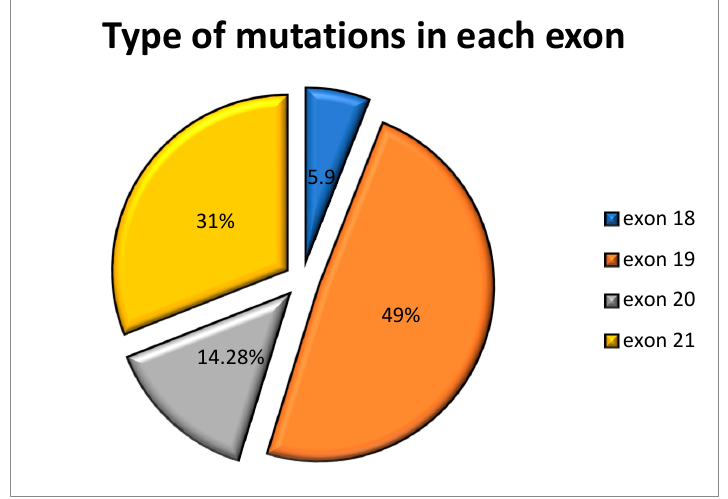
Figure 2. Percent representation of mutations present in EGFR gene exons 18, 19, 20, and 21. Table 2 provides the exon location of EGFR mutations according to different lung cancer types. Only adenocarcinoma samples showed EGFR mutations in all four exons tested, i.e., 18, 19, 20, and 21. Squamous cell carcinoma and adenosquamous carcinoma had mutations in three of the four exons, 18, 19, 21, and 18, 20, 21, respectively, carcino- sarcoma in exon 21, undifferentiated carcinoma in exon 19, and sarcomatoid carcinoma in exon 18. Two of three adenosquamous carcinoma patients showed double mutations. Table 2. Histological classification of lung cancer types based on the location of EGFR mutations. Histology Type